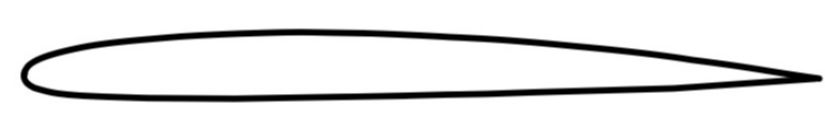
Figure 2. Profile of NACA2408 airfoil.